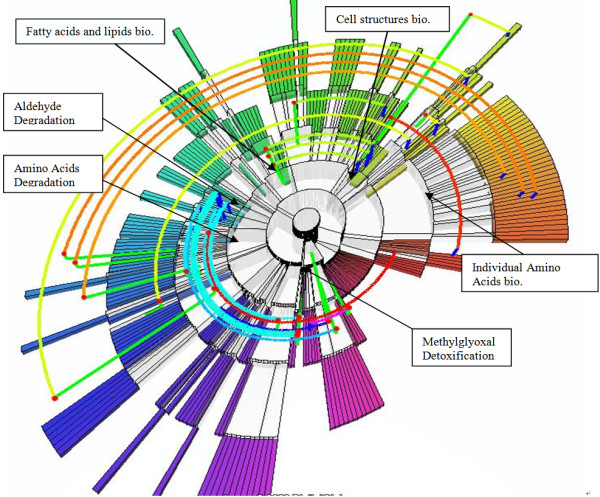
Pathway ontology shown with proposed ERSF layout. The hierarchical structure of the ontology is clear in this view. The depth of the ontology tree, six, can be seen by counting the number of rings in the display. There are many pathways that belong to at least two categories, e.g., three pathways from individual amino acids biosynthesis (on right) also belong to the category amino acids degradation (on left). Also many pathways from aldehyde degradation (on the left of 3rd layer) belong to the category methylglyoxal detoxification. This kind of multiple inheritance information is difficult to see in other visualization methods.